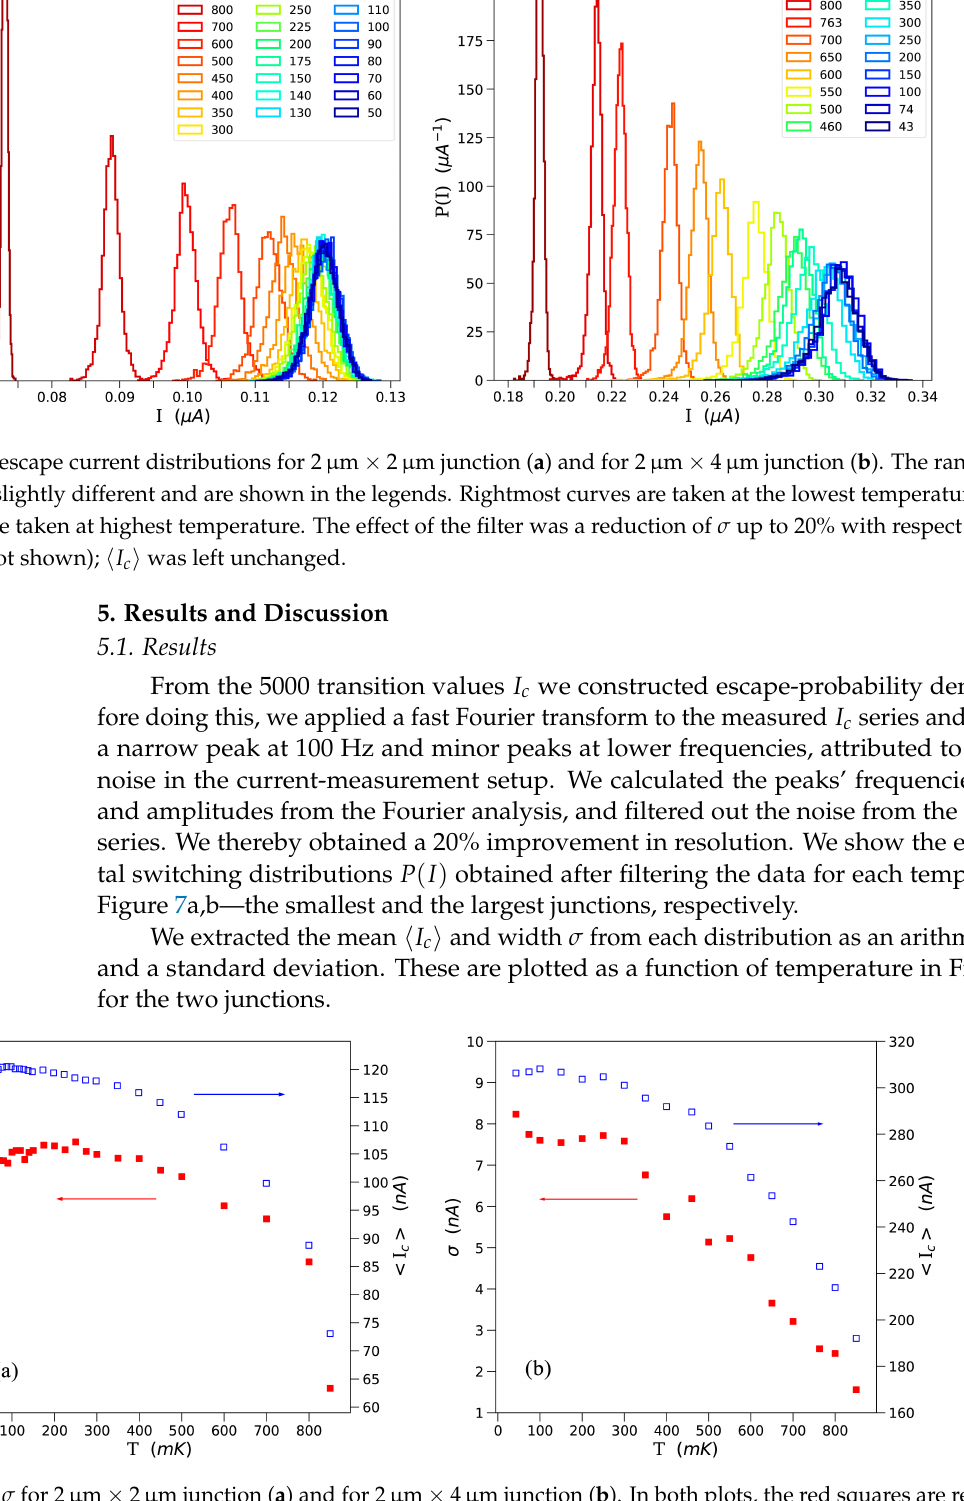
and σ for 2 µ m 2 µ m junction ( a ) and for 2 µ m 4 µ m junction ( b ). In both plots, the red squares are relative Figure 8. I c (cid:104) (cid:105) × × to the left axis (widths) and the empty blue squares are relative to the right axis (mean currents), as indicated by the arrows. The mean critical current values (empty blue squares) follow qualitatively the typical BCS behavior [52] as a function of temperature. The widths (full red squares) present a peculiar feature. The constant behavior of σ at low temperatures was expected